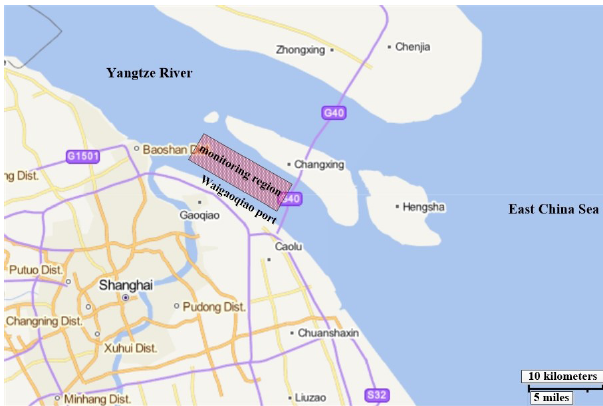
Figure 1. Image of the UAV system. A gas probe, camera, and pod are installed under the unmanned aerial vehicle (UAV). The gas probe is used to collect the ship’s exhaust gas, and the camera is used to assist in finding the ship’s funnel mouth during flight. The pod is used to carry a gas pump, gas circuit, filter, small motor, sen- sors for SO 2 and CO 2 , and communication modules.